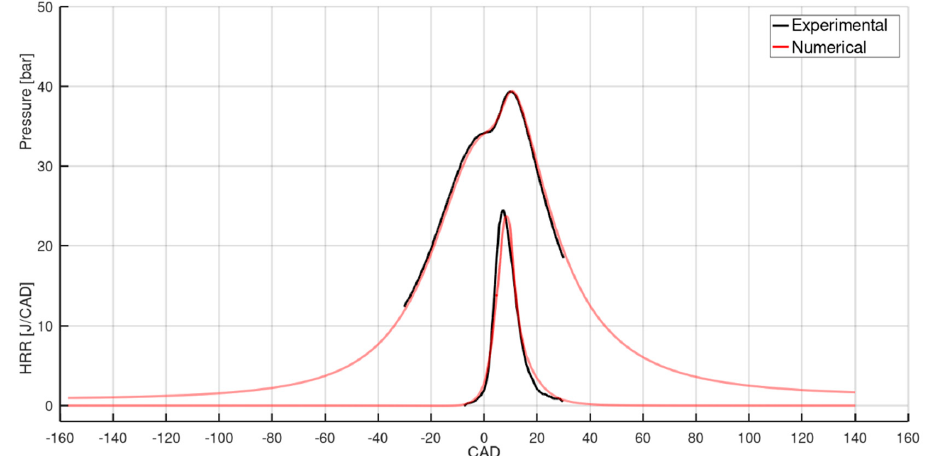
Figure 2. Comparison between experimental and numerical results in terms of in-cylinder pressure and heat release rate (HRR).